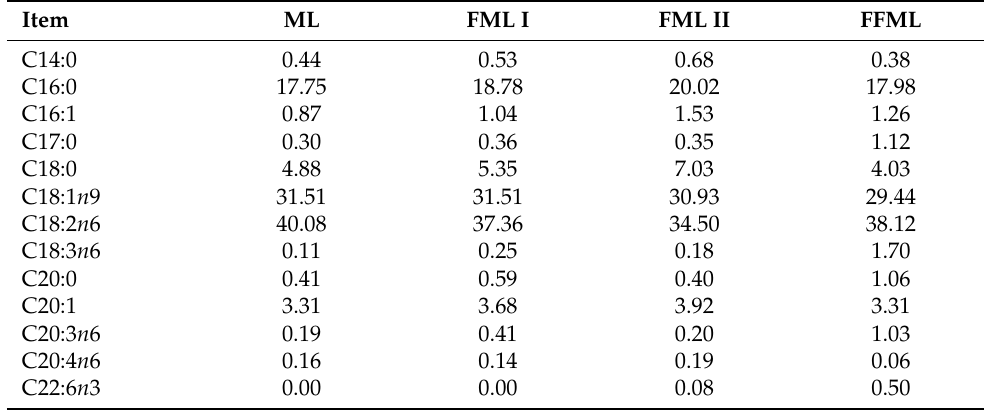
Table 3. Long-chain fatty acids (LCFAs) composition of Mao-tai lees and fermented Mao-tai lees (% of total